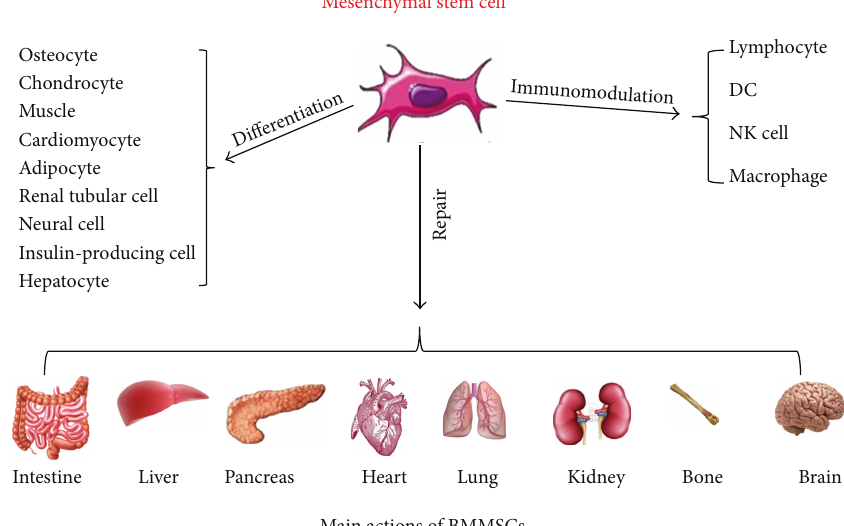
Figure 1: Main actions of